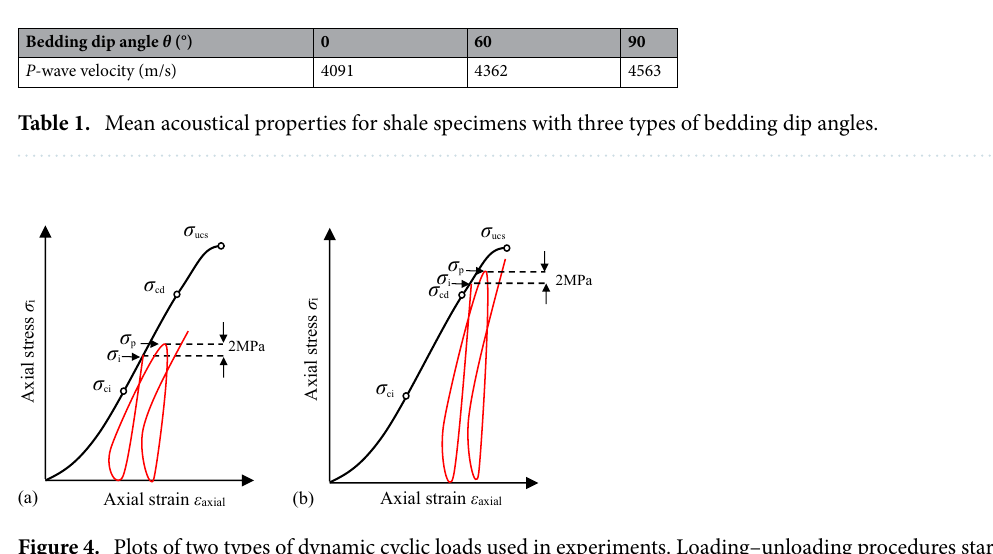
Figure 4. Plots of two types of dynamic cyclic loads used in experiments. Loading–unloading procedures start after an initial stress σ i has been applied to the value ( a ) larger than σ ci and smaller than σ cd , and ( b ) larger than σ cd and smaller than σ ucs . The subsequent peak stress ( σ p ) per cycle had a 2 MPa increment until final failure